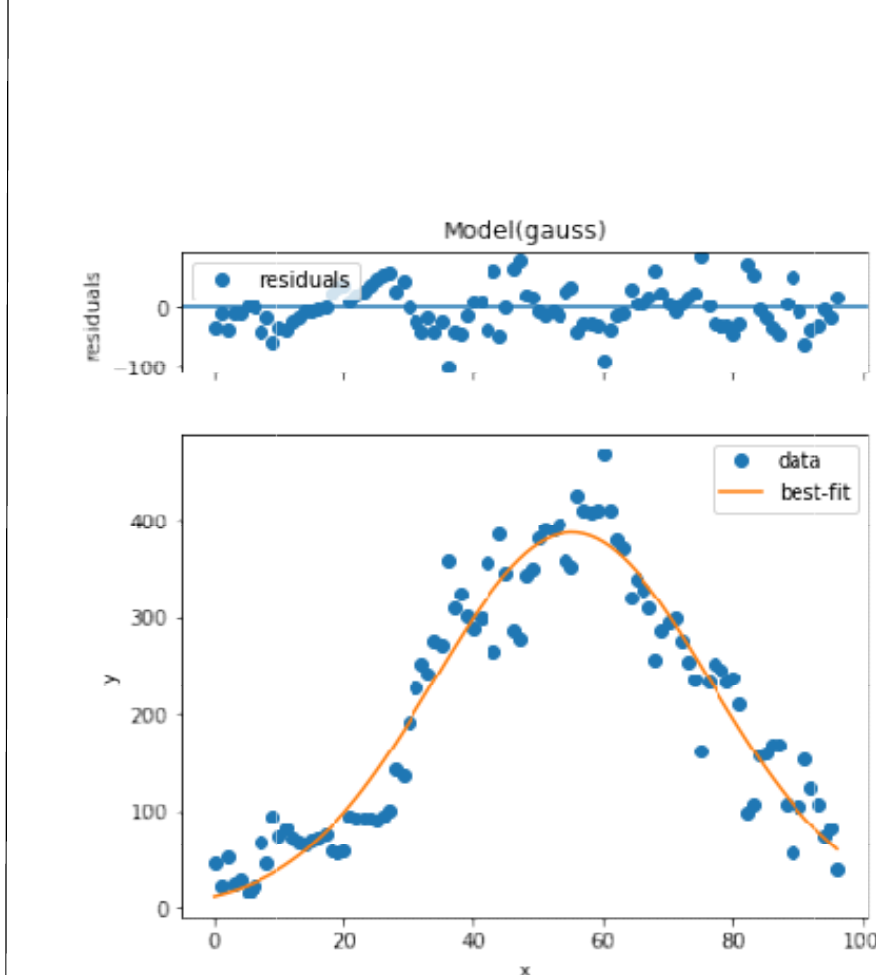
Figure 3 – INSTRUMENT 2: INSTRUMENT 2: Fitting a Gaussian curve using residuals.